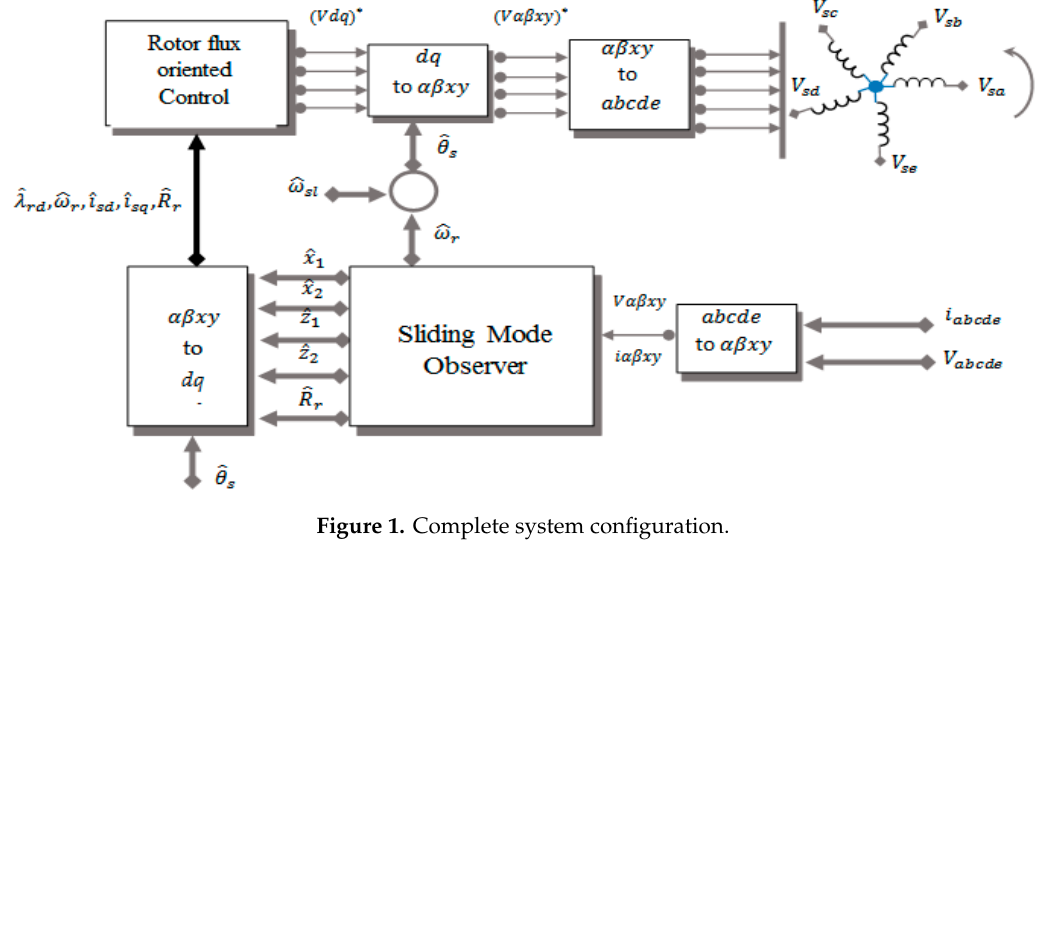
Figure 2. Block diagram of real time implementation. The simulation is performed to test the feasibility of the proposed observer while implementing the indirect rotor-field orientation (IRFO) control and investigating the speed tracking performance. The results are illustrated in Figure 3a–g. The motor started running with its nominal speed and then the speed is reversed, keeping the rotor resistance value 𝑅 (cid:3045)(cid:3041) = 2.4 . Then, the value of 𝑅 (cid:3045) is increased and set to 𝑅 (cid:3045) = 1.5 ∗ 𝑅 (cid:3045)(cid:3041) (This is to investigate the robustness of the proposed SMO against the parameters change.). Figure 3a,b presents the speed response (observed and reference) and